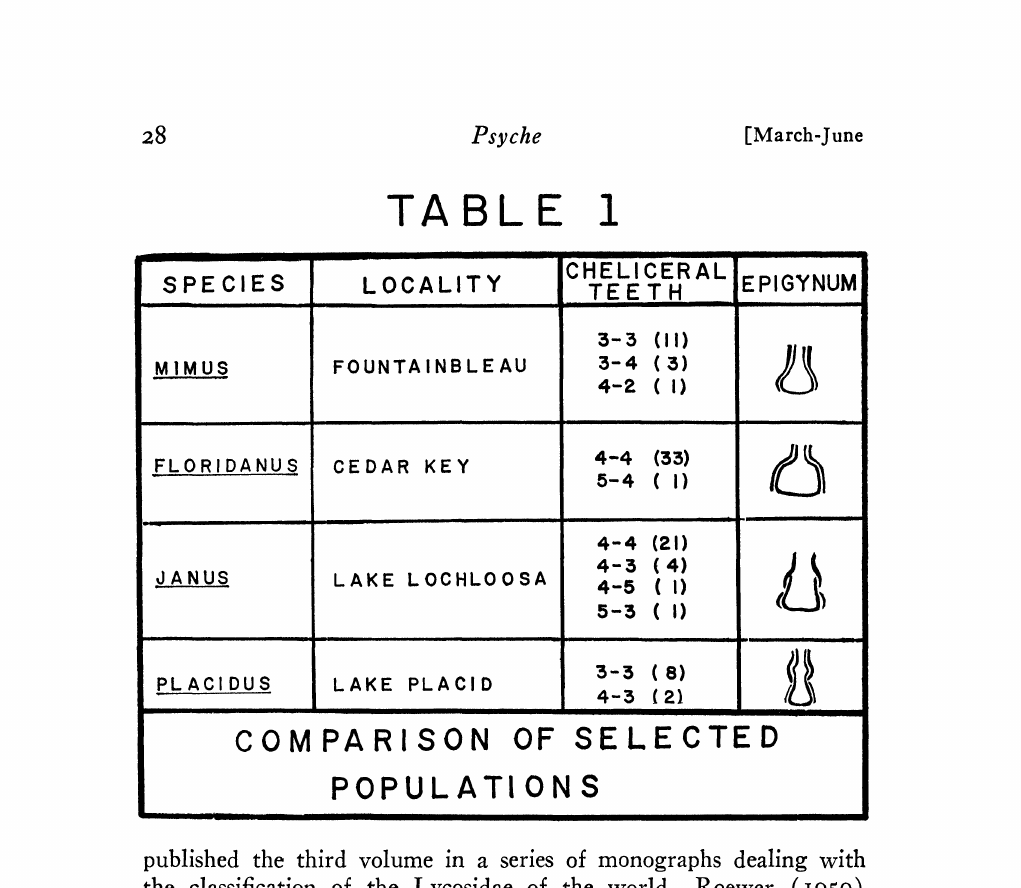
SPE CIES LOCALITY TEETH